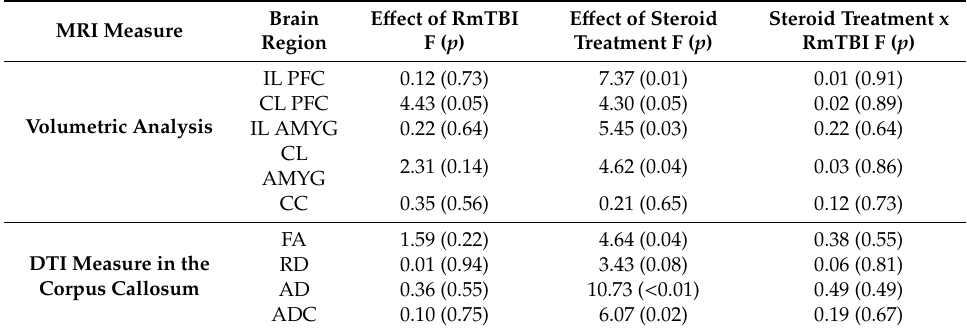
Table 1. Statistical results of the two-way ANOVAs for MRI-related outcomes (Volume and DTI) after RmTBI and steroid treatment.